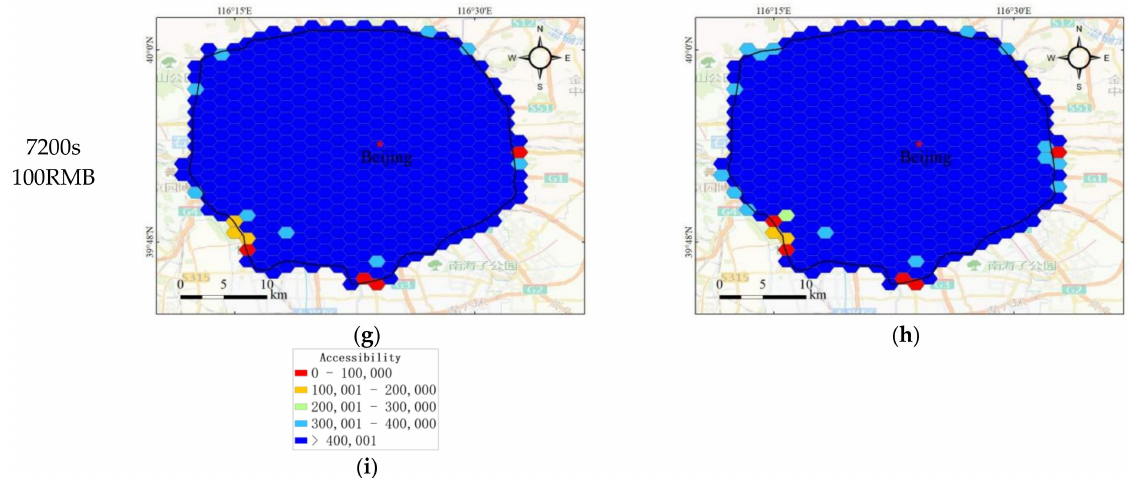
Figure 8. Accessibility of Beijing Fifth Ring Road: ( a – h ) the accessibility under different conditions, and ( i ) the colorimetric bar of accessibility. (Note: there are 502,180 POIs within Beijing’s 5th Ring Road, and the equalization method is used to classify the accessibility level, which is divided into five levels after rounding).